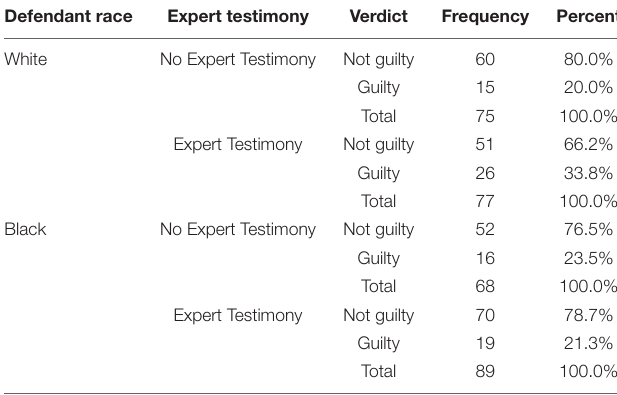
TABLE 3 | Voluntary manslaughter verdicts by defendant race and expert testimony.